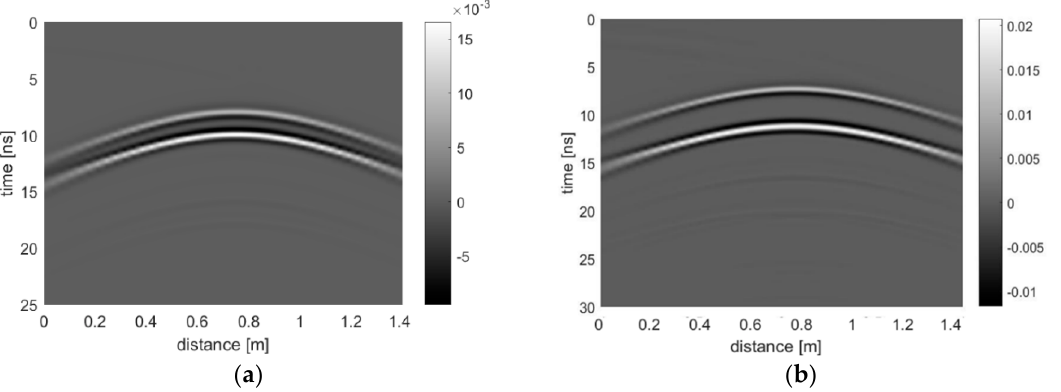
Figure 4. B-scan radargrams simulated for the scattering layout in Figure 3, with one buried dielectric cylinder ( ε rc = 7, ε r 1 = 7, h = 50 cm, f 0 = 600 Mhz): ( a ) radius a = 5 cm; ( b ) radius a = 10 cm.